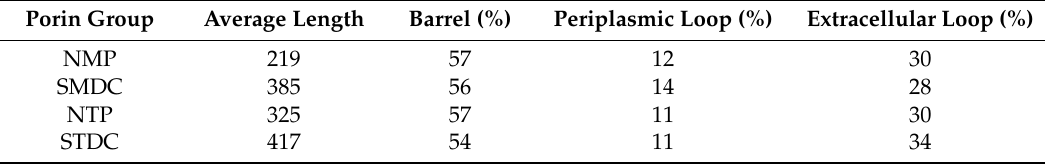
Table 2. Secondary structure composition. Secondary structure composition of the average non-specific porin and specific diffusion channel composition, which lists the average length (number of amino acids), percentages of amino acids located in β -strands, periplasmic loops and extracellular loops. Porin